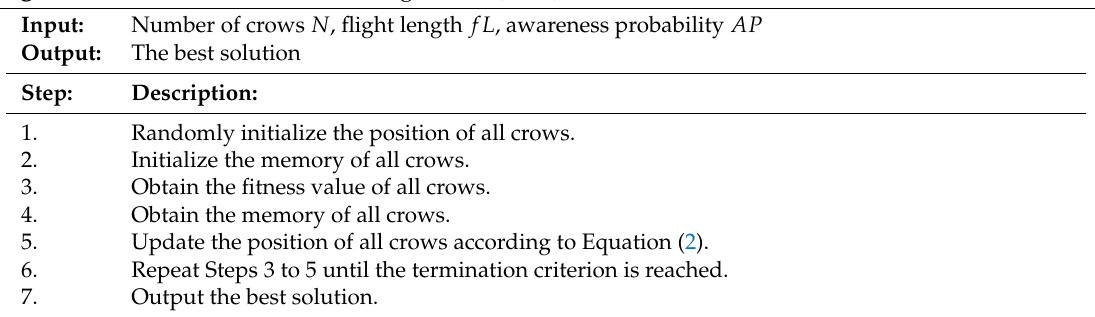
Algorithm 2 Standard crow search algorithm (CSA).